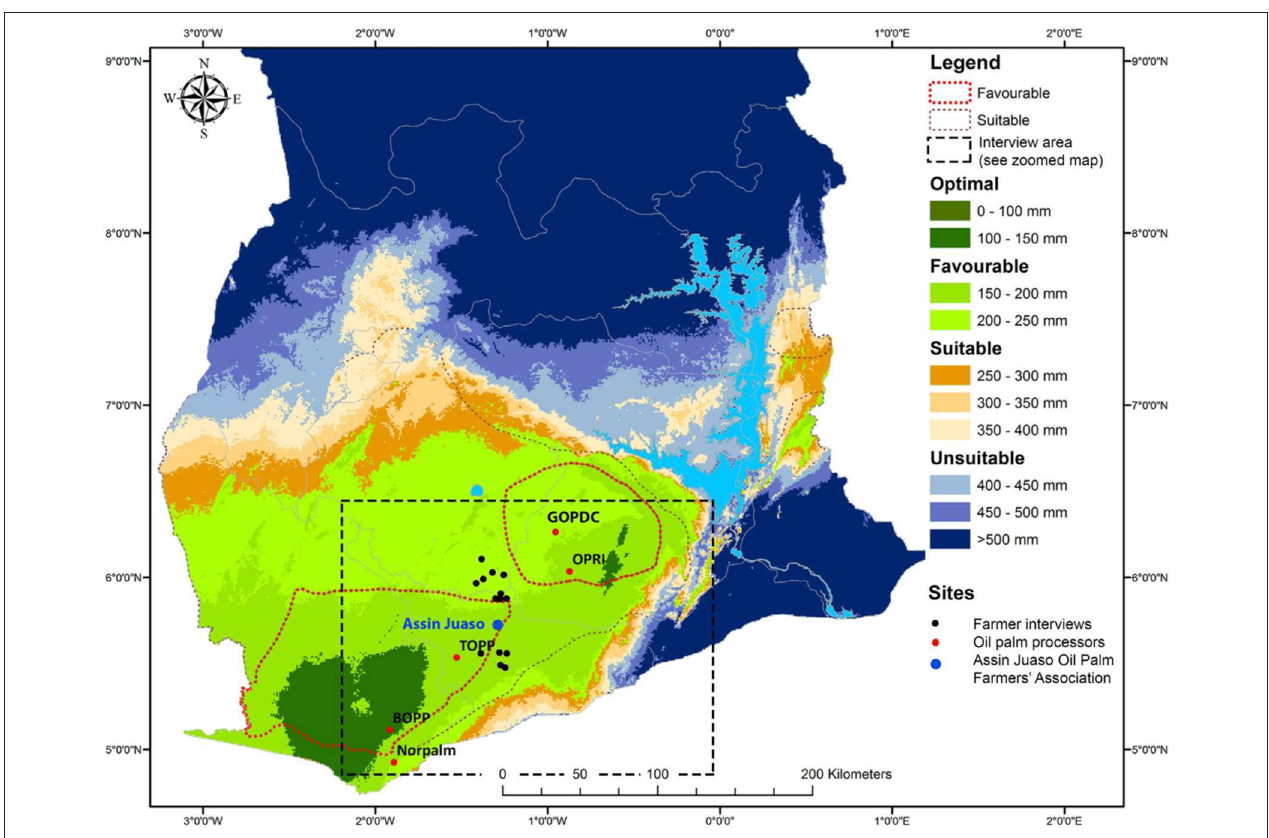
FIGURE 1 | Map of southern Ghana (including the Central and Ashanti Regions) showing areas climatically suitable for oil palm production. Numbers in mm represent soil water deficit. Source: reprinted and adapted with permission from Rhebergen et al. (2016). The black dotted area covers our study areas (and Ghana’s five major oil palm